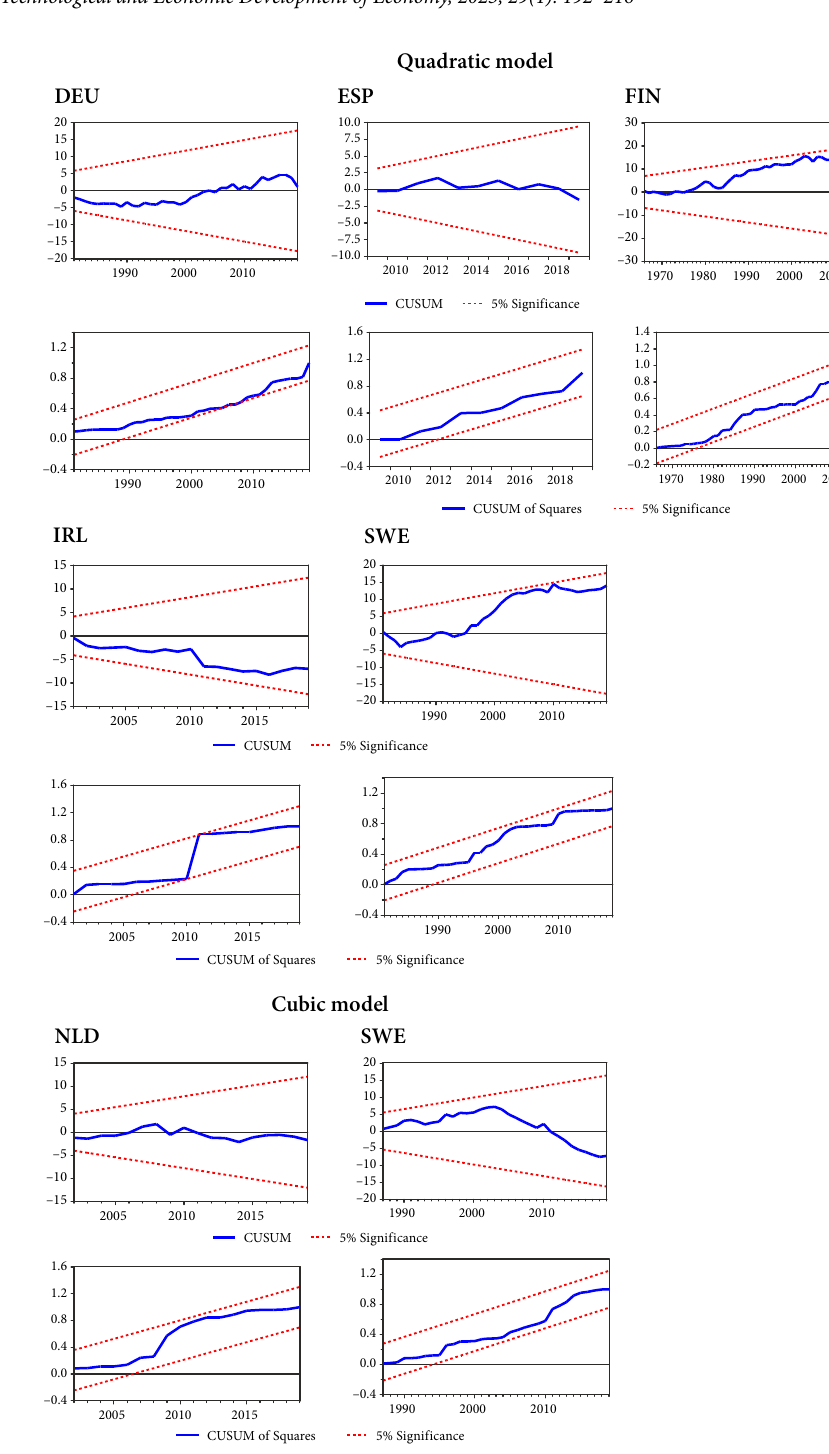
Figure 4. Plots of the CUSUM and CUSUMSQ stability tests statistics